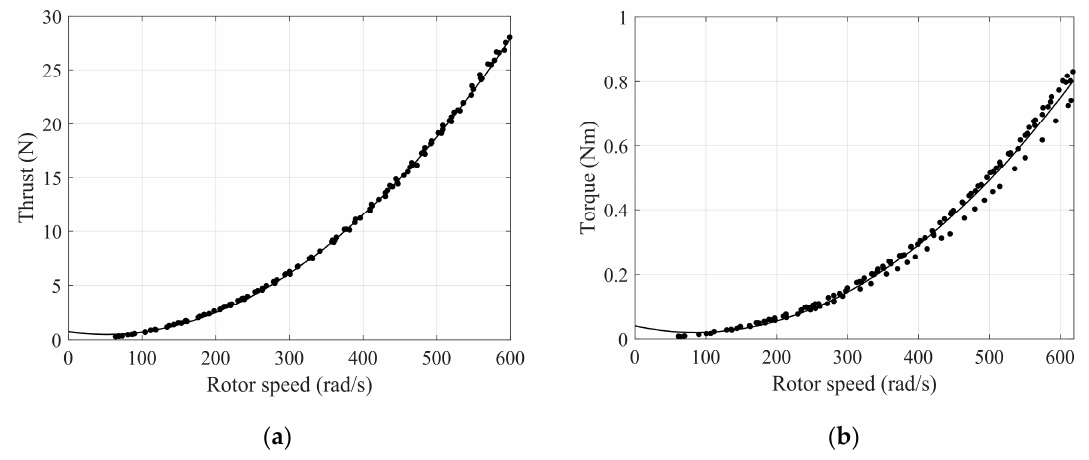
Figure 5. Measurements and fitting curves. ( a ) Trust curve; ( b ) torque curve.